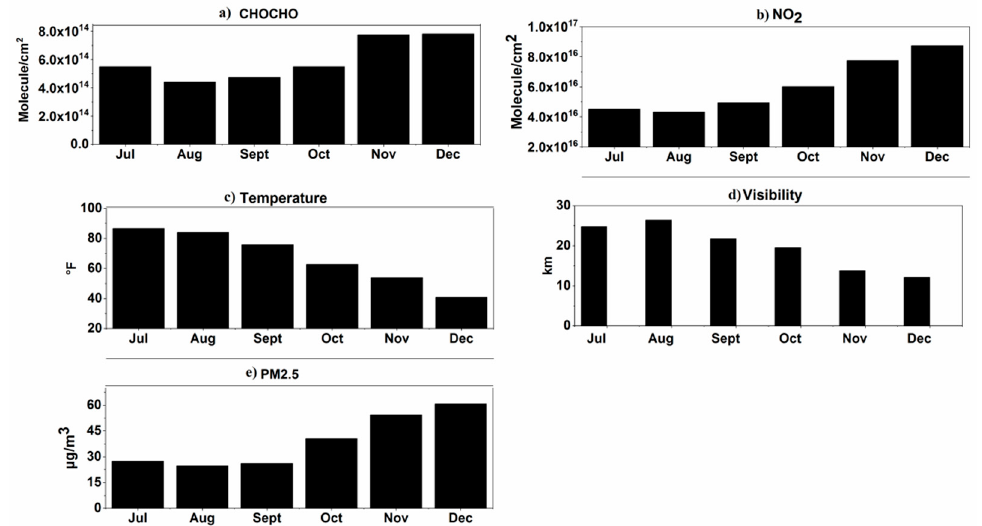
Figure 5. Monthly variations in ( a ) CHOCHO, ( b ) NO 2 , ( c ) temperature, ( d ) visibility, and ( e ) PM2.5.